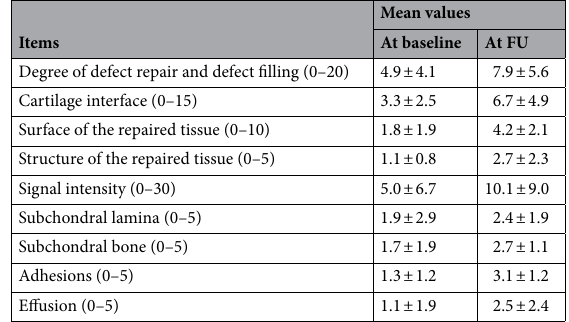
Table 3. Results of the MOCART score for each item (FU: